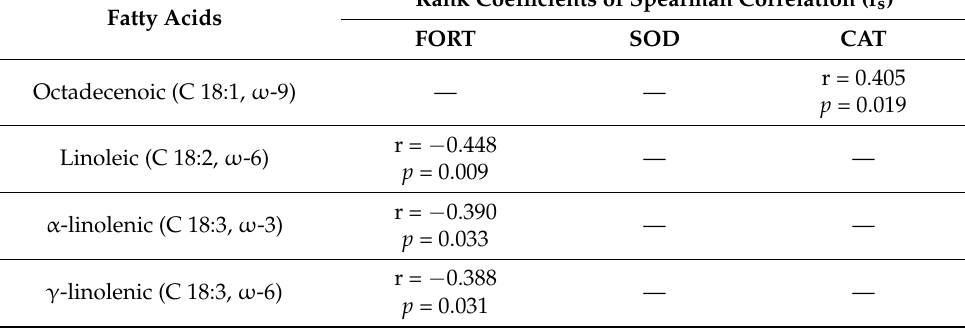
Table 5. The associations between the content of FAs and the antioxidant system enzymes in men with ischemic artery disease and the absence of vulnerable atherosclerotic plaques in the coronary arteries (Subgroup